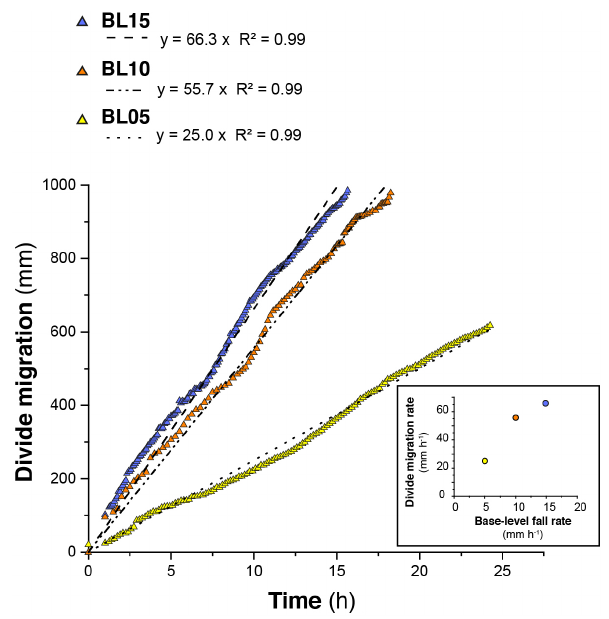
Figure 5. Evolution of the water divide position within the erosion box for the three experiments. The inset figure (bottom right panel) shows the relation between the divide migration rate in the three experiments and their related base level fall